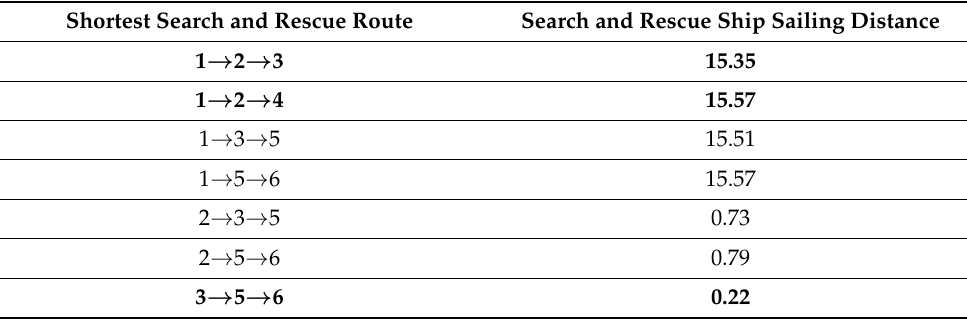
Table 3. Floyd–Warshall algorithm shortest search and rescue route